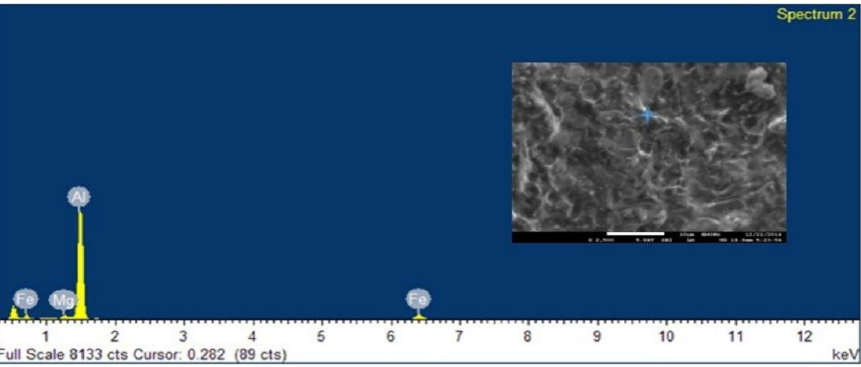
Figure 16. EDX analysis of kissing bond fracture location.